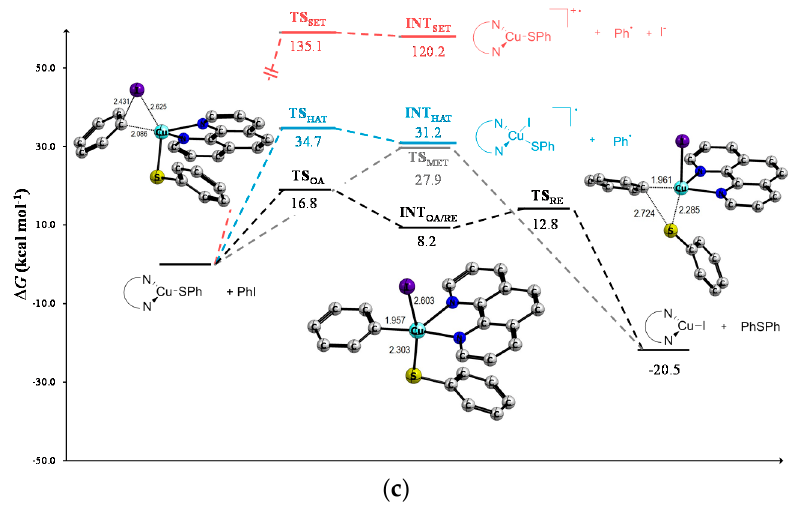
Figure 2. Computed Gibbs energy profile ( Δ G [kcal/mol] at 298.15 K) at the B3LYP + D3(BJ)/def2 ‐ TZVPP//B3LYP/def2 ‐ SVP of the cooper ‐ catalyzed cross ‐ coupling reaction: ( a ) PhI ( 1 ) and aniline ( 2 ‐ NH ); ( b ) PhI ( 1 ) and phenol ( 2 ‐ O ); ( c ) PhI ( 1 ) and thiophenol ( 2 ‐ S ). Oxidative Addition–Reductive Elimination (OA ‐ RE) ( — ); Methatesis (MET) ( — ); Halogen Atom Transfer (HAT) ( — ) and Single Electron Transfer (SET) ( — ). The hydrogen atoms attached to carbon atoms are omitted for clarity.